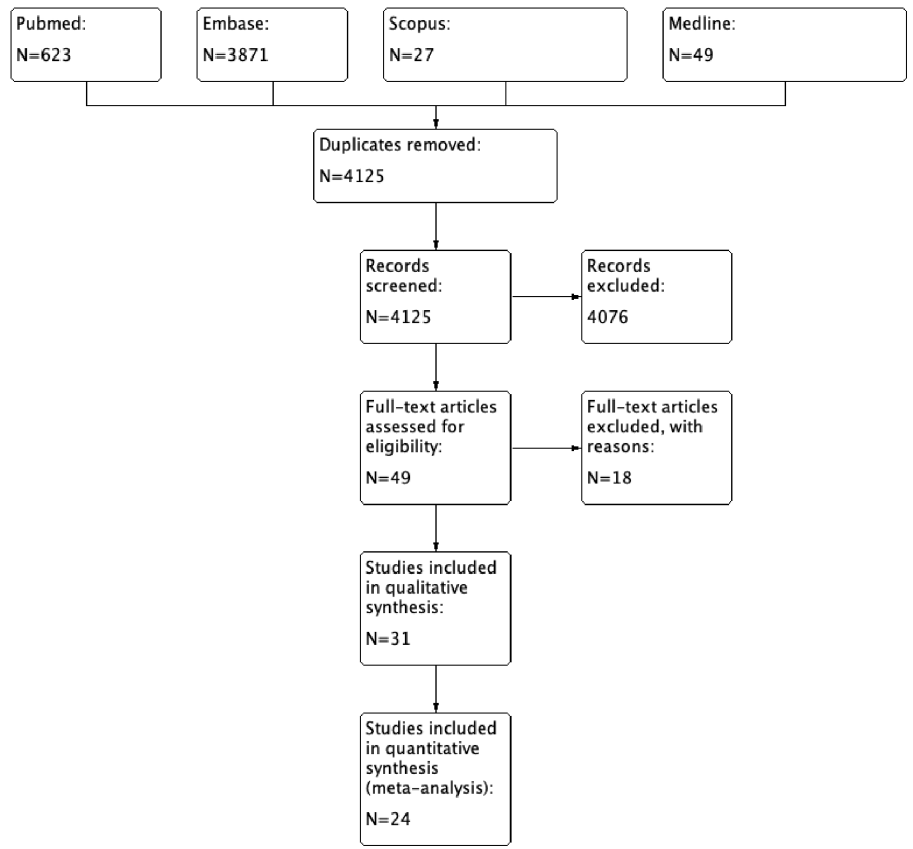
Fig 1. PRISMA study flow